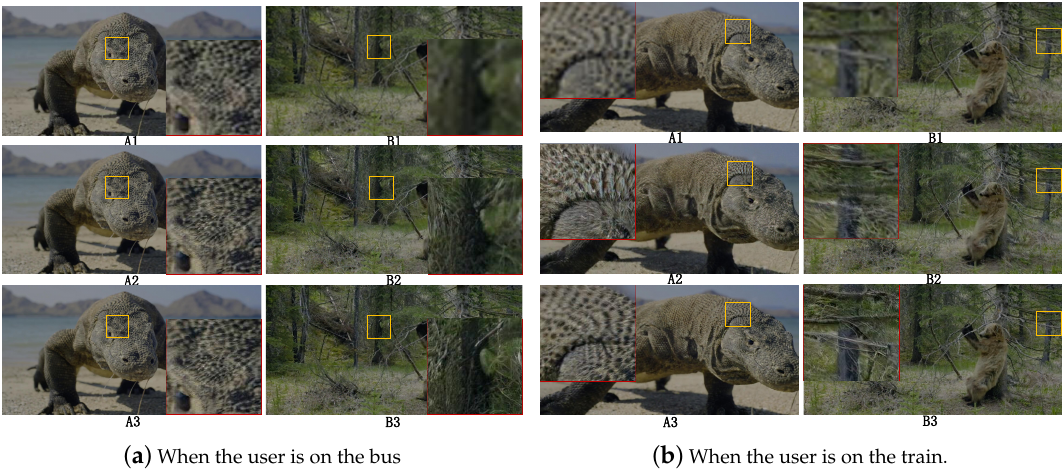
Figure 9. Images in video frame comparison results.